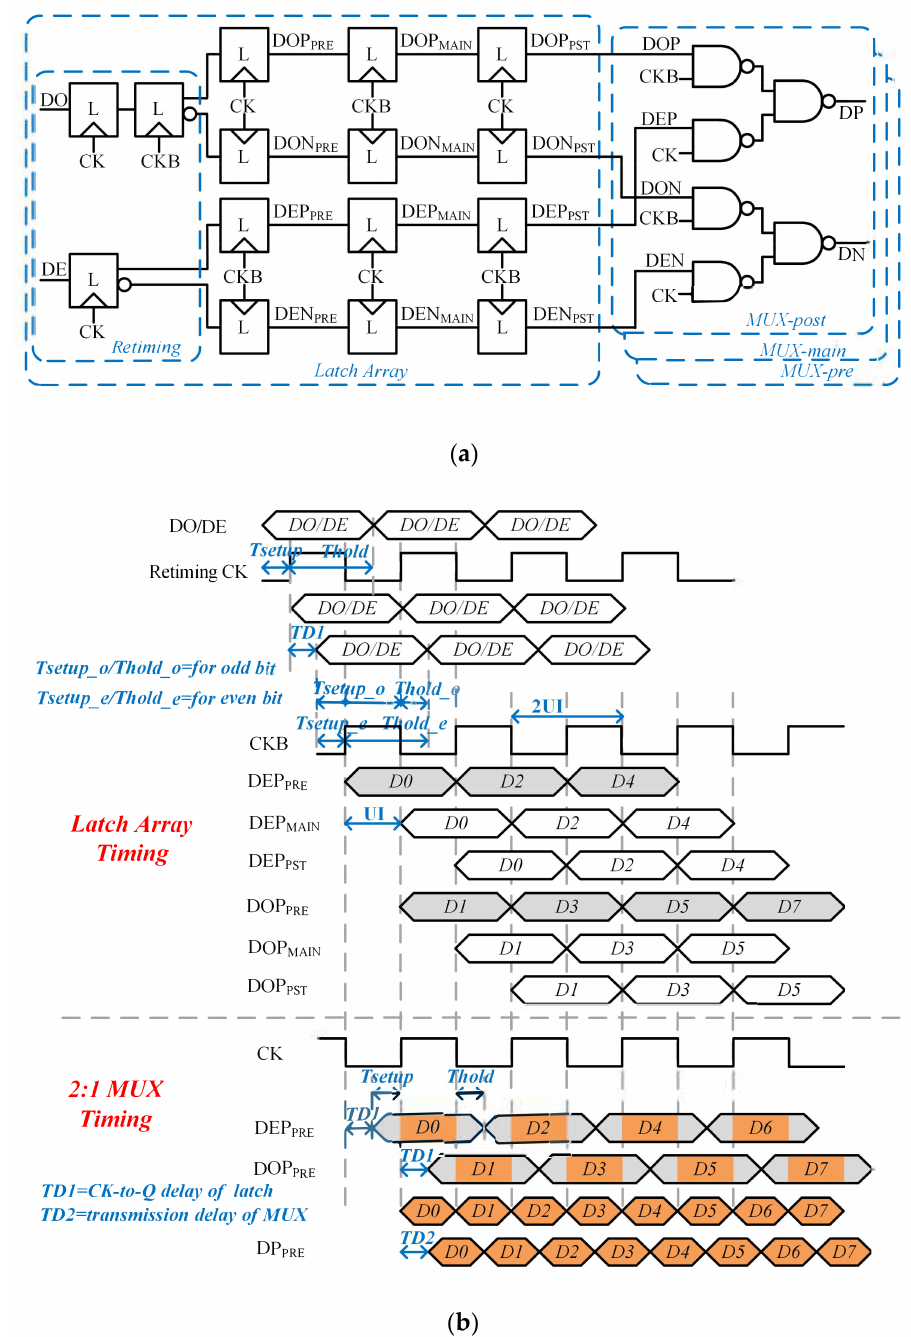
Figure 3. ( a ) The details and ( b ) timing diagram of the latch array and 2:1